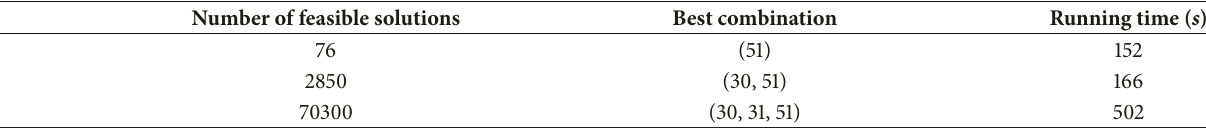
Table 4: Test results of the calculation of 𝐺 𝑉 (0) in Sioux-Falls